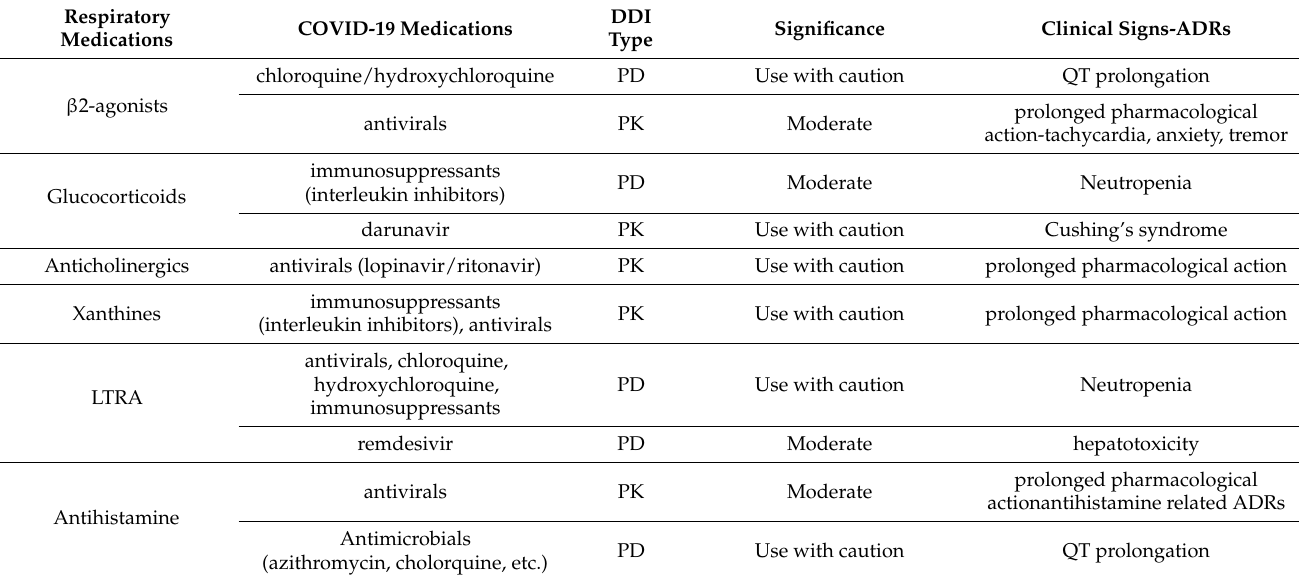
Table 3. DDIs mechanism and significance between drugs used in respiratory disorders and COVID-19 medications along with potential ADRs that may occur in those